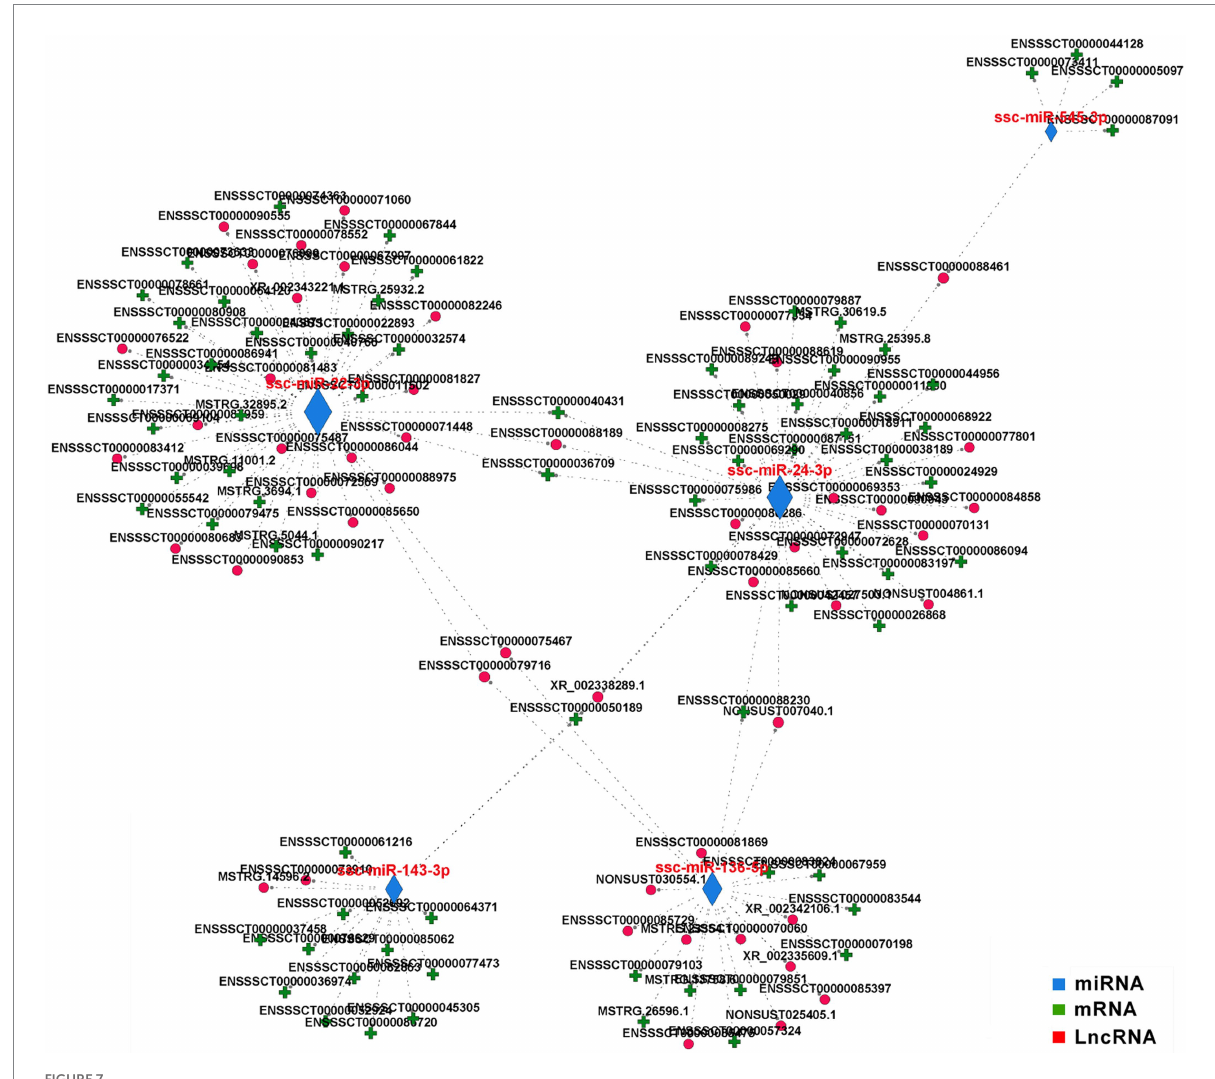
FIGURE 7 Competing endogenous (ce) RNA network in the hypothalamus. The ceRNA network was constructed based on lncRNA/miRNA and miRNA/ mRNA interactions with correlation >0.9 and padjust < 0.05. The edges represent sequence matching, and lncRNAs connect expression-correlated mRNAs via